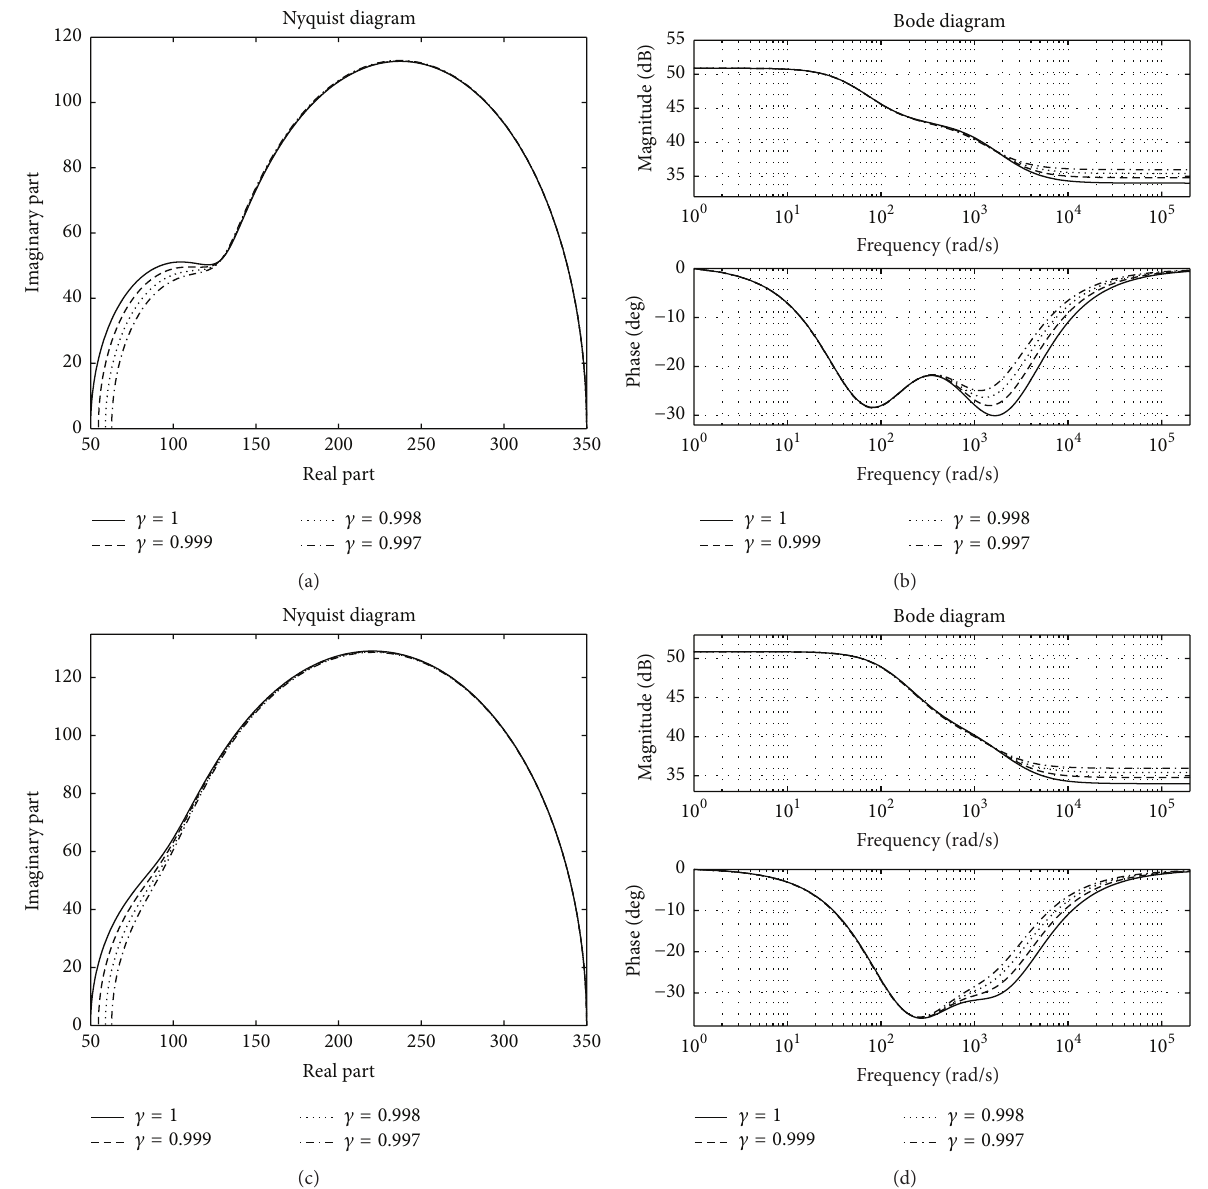
Figure 6: Nyquist and Bode diagram for the heterogeneous reaction model, Caputo-Fabrizio derivative approach, in (a) and (b): 𝑅 1 = 50 Ω , = 100 Ω , 𝑅 = 200 Ω , 𝐶 = 1 −3 F, and 𝐶 = 1 −2 F for 𝛾 = 1 , 𝛾 = 0.999 , 𝛾 = 0.998 , and 𝛾 = 0.997 ; for (c) and (d), 𝑅 𝑅 2 3 1 2 = 200 Ω , 𝐶 = 1 −3 F, and 𝐶 = 3 −3 F for 𝛾 = 1 , 𝛾 = 0.999 , 𝛾 = 0.998 , and 𝛾 = 0.997 . The capacitor 𝐶 𝑅 3 1 2